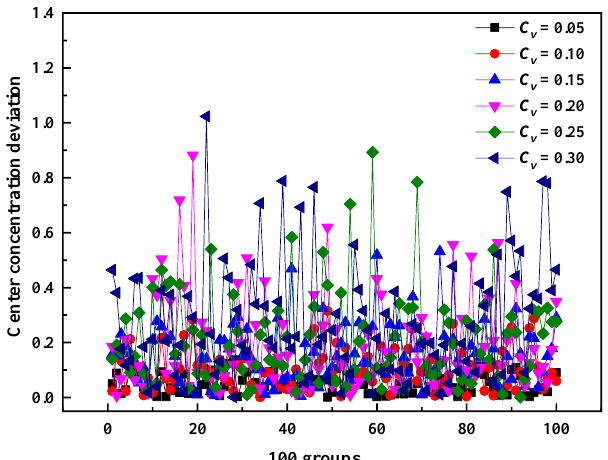
Figure 30. Center concentration deviation under different relative standard deviations of velocity at velocity 5.05 m/s.